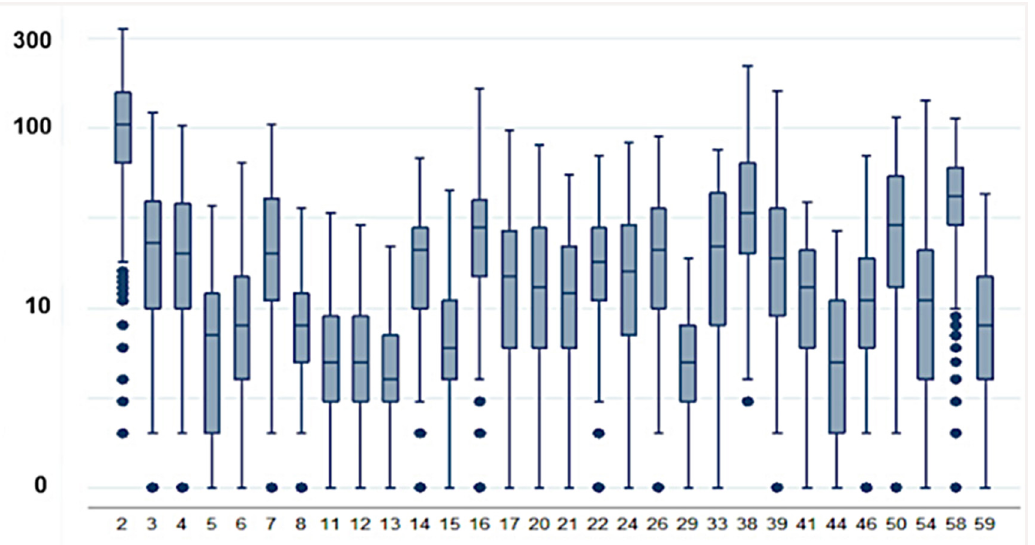
Fig 3. Linguistically Inferred Emotional Activation Levels. Each boxplot represents a trader ’ s distribution of daily instant messages expressing emotional activation as inferred from the linguistic content of their sent instant messages. Traders ’ anonymous IDs are identified by the numbers on the x axis. Comparably distributions of emotional activation have been identified in traders from physiological measurements